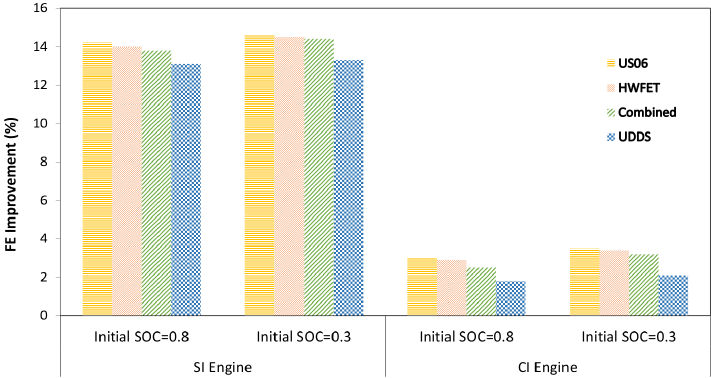
Figure 19. HEV fuel economy (FE) improvement by using the RCCI engine versus the SI and CI engines in four different driving cycles (EMC: 3-mode DP).